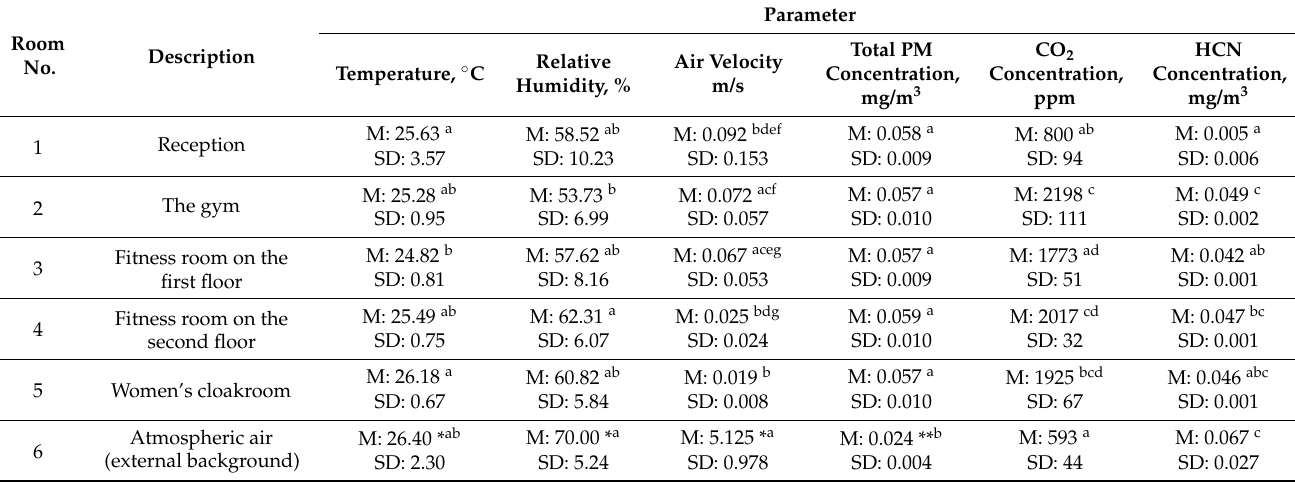
Table 1. Air quality parameters at the tested